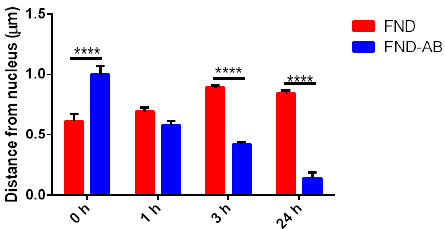
Figure 5. Distance measurement from particles to the border of the nucleus. Experiments were performed in 10 cells. Significance level was set at 0.05. **** indicates p < 0.0001. Error bars represent standard errors.